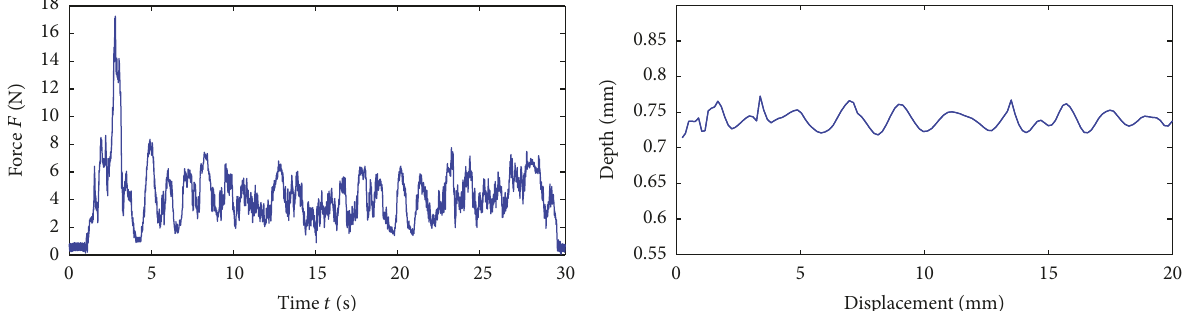
Figure 10: Experiment result of robotic machining under open loop control.